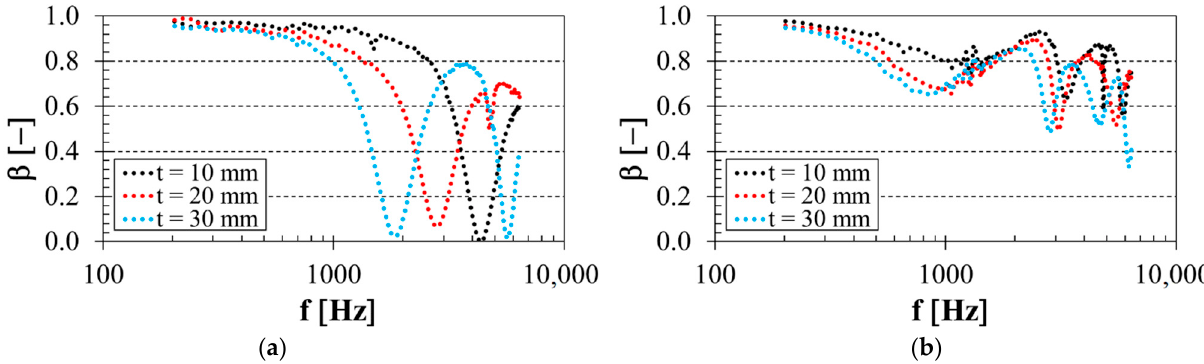
Figure 6. Effect of specimen thickness on the frequency dependencies of the sound reflection coefficient for the investigated PLA specimens: ( a ) Starlit structure, porosity P = 30%, air gap size a = 0 mm; ( b ) Octagonal structure, porosity P = 56%, air gap size a = 60 mm.